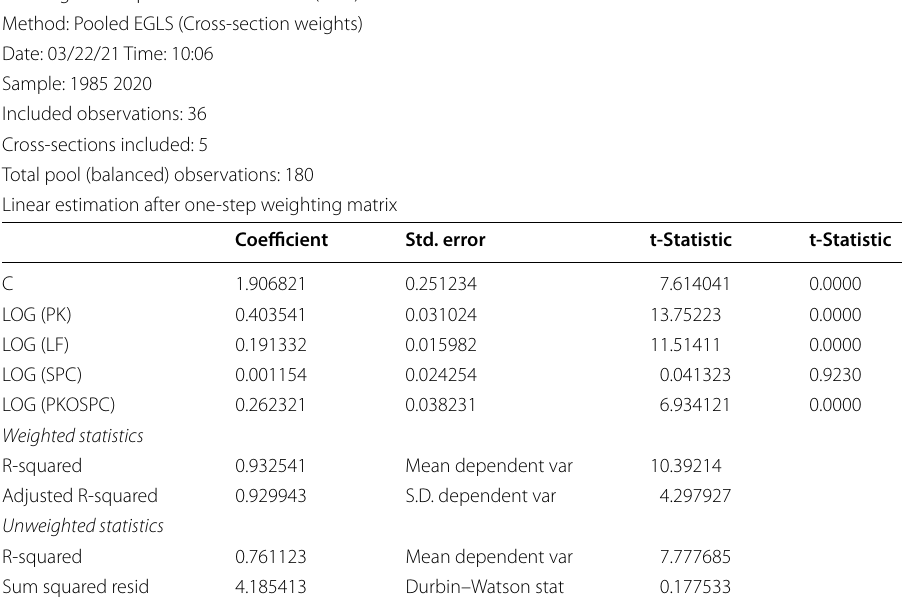
Table 1 Results of the global estimation of Eq. 3 on panel data Heading level dependent variable: